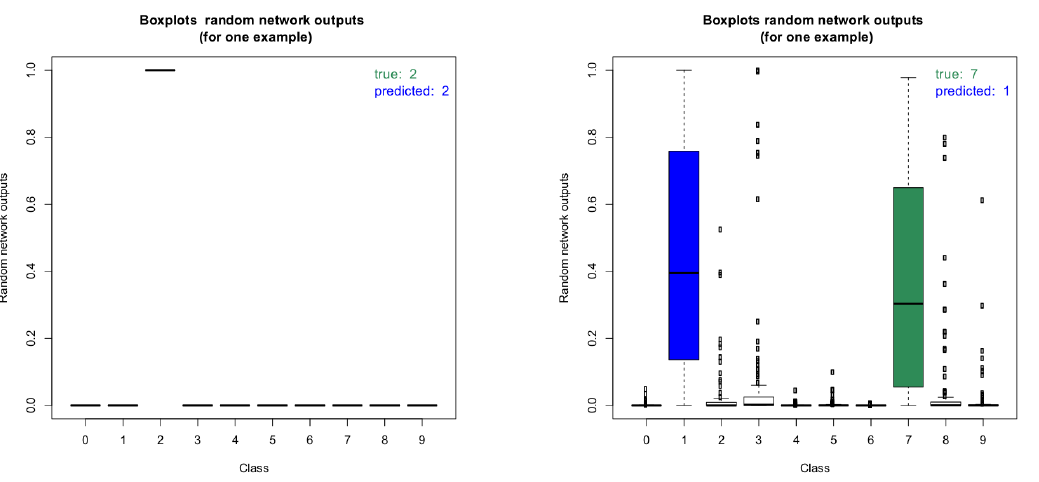
Figure 10. Boxplots of the random network outputs of two representative images of the MNIST dataset. Left: Boxplot of a correct classification, right: boxplot of an incorrect classification